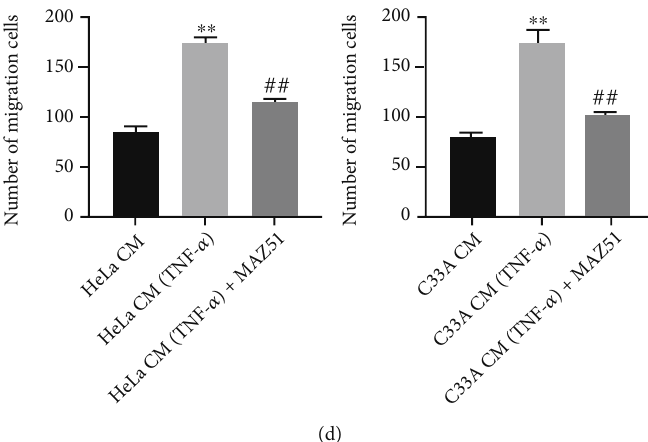
Figure 3: CM-TNF- α increases the migration of HLECs. Cervical cancer cells (HeLa and C33A) were stimulated with 10 ng/ml TNF- α for 48h, and corresponding CM was collected. Next, HLECs were cultured in CM with or without MAZ51 treatment. (a, b) The migration of HLECs was measured by wound healing assay. (c, d) The migration of HLECs was measured by transwell migration assay. ∗∗ P < 0 : 01 compared with CM group; ## P < 0 : 01 compared with CM-TNF- α group, n = 3 .